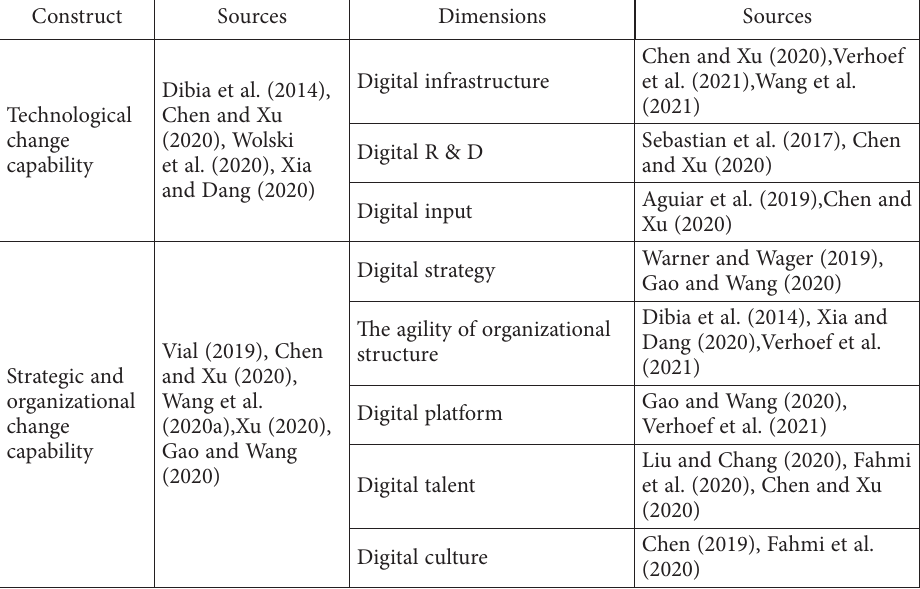
Table 5. The DTC model of retailers (source: Chen & Xu, 2020; Verhoef et al., 2021, etc.) Construct Sources